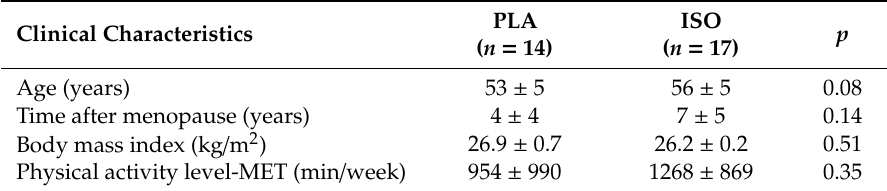
Table 1. Characteristics of participants ( n =